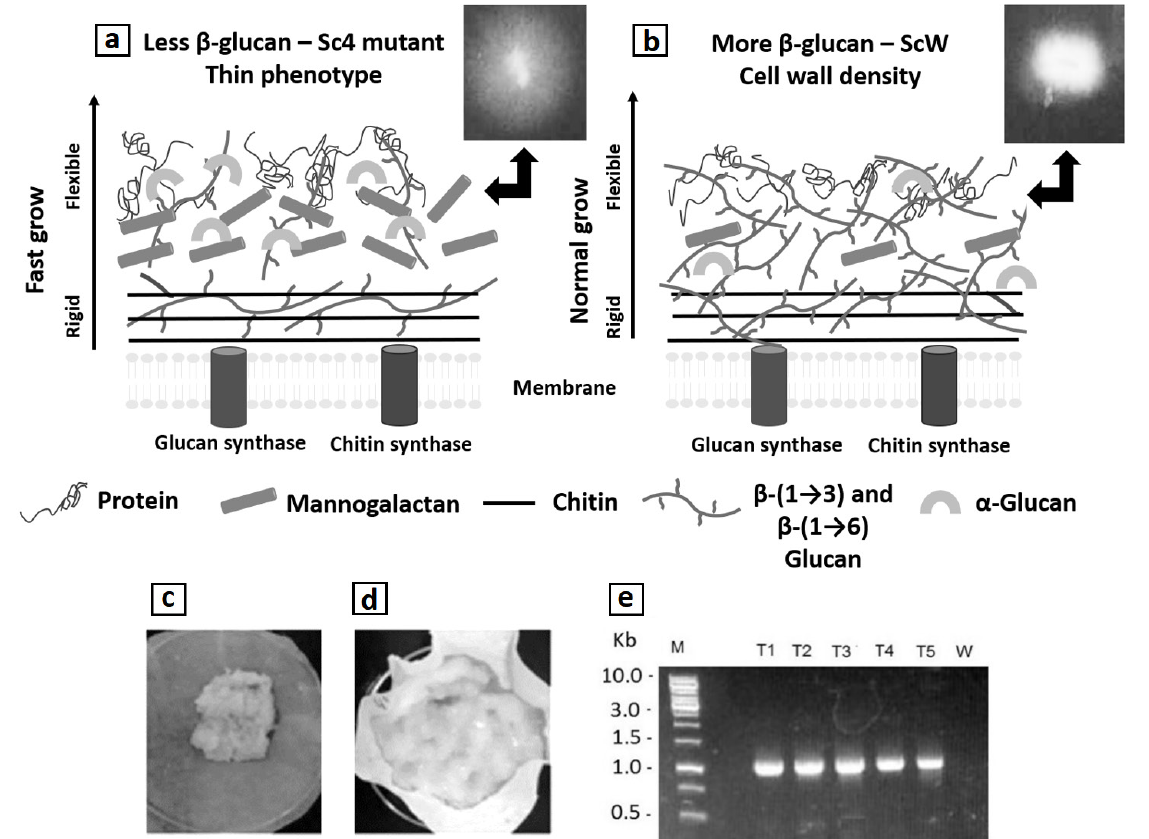
Figure 3. Hypothetical representation of cell wall structure and phenotypic characteristics of S. commune . a - ScT4 mutant phenotype presenting less thick mycelium; b - Phenotype of wild mycelium; c - Biomass of hygromycin resistant mutant phenotype after liquid culture; d - Wild phenotype biomass; e - PCR amplification of the hygromycin resistance gene for the S. commune mutants T1, T2, T3, T4, T5 and for the wild type